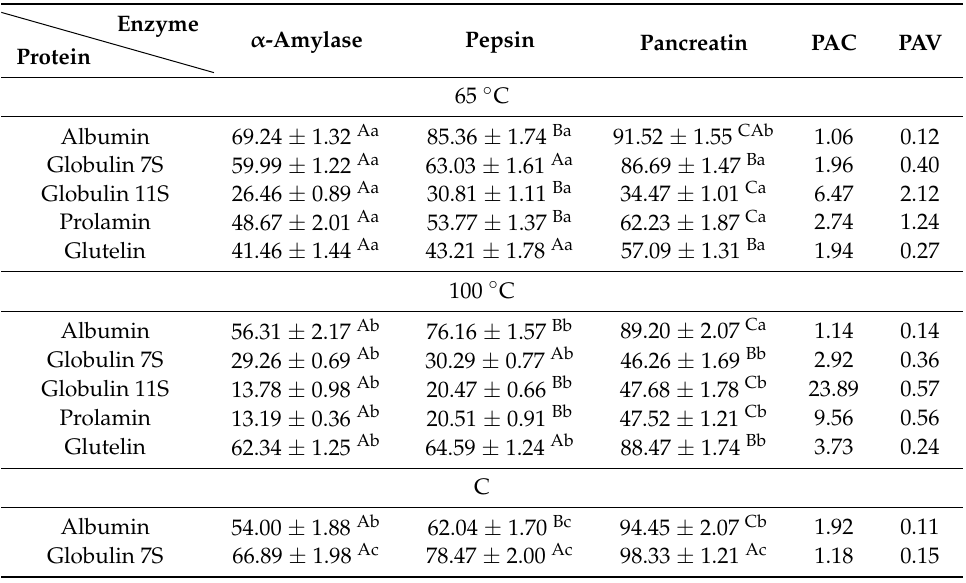
Table 1. Degree of hydrolysis (DH) (%) of protein fractions during hydrolysis under gastrointestinal conditions and potential bioaccessibility (PAC) and potential bioavailability (PAV)